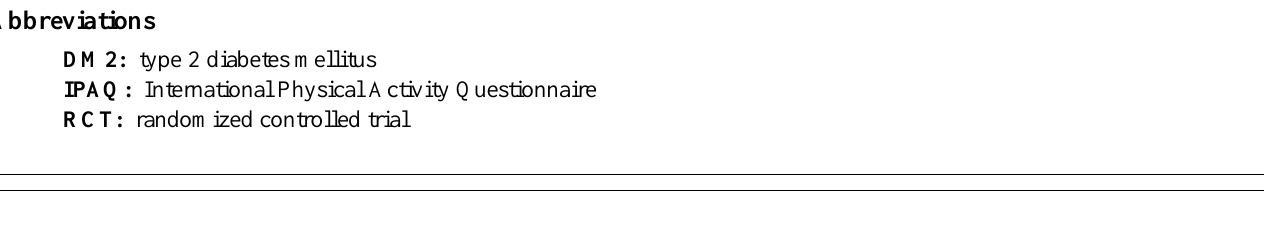
DM2: type 2 diabetes